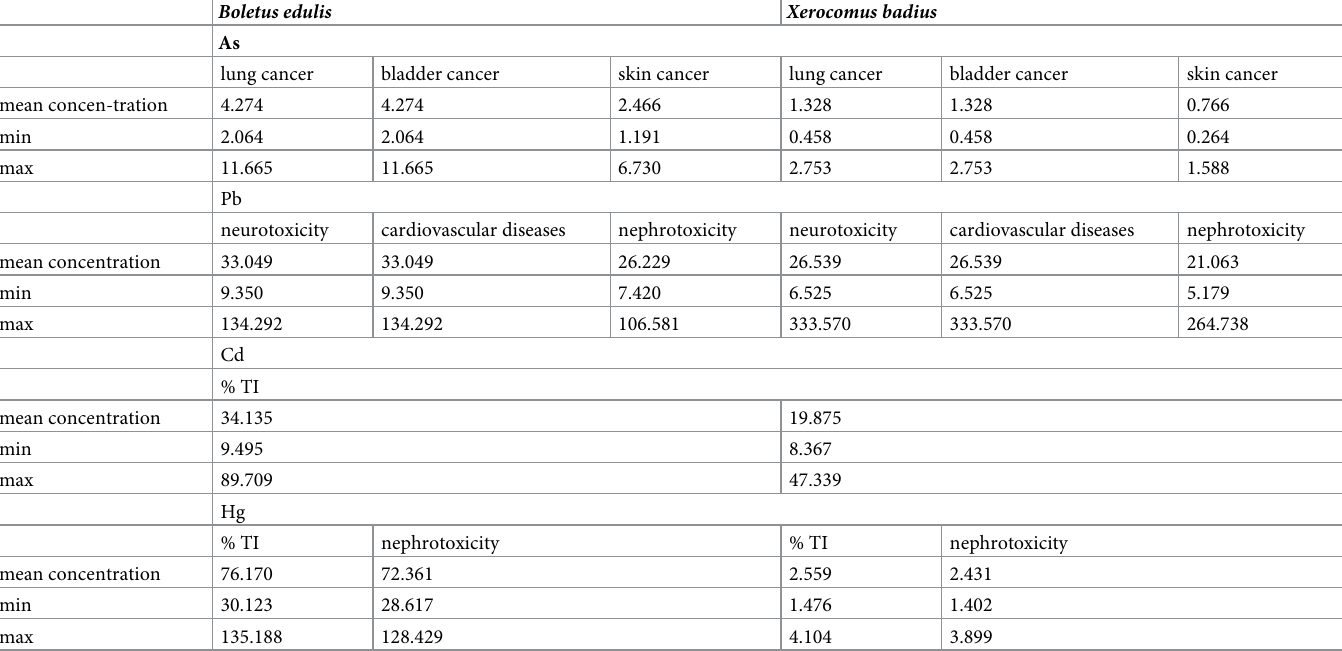
Table 5. Estimated contribution (%) in a daily toxic dose resulting from the consumption of a standard portion (10 g) of dried mushrooms by a person with an aver- age body weight of 70